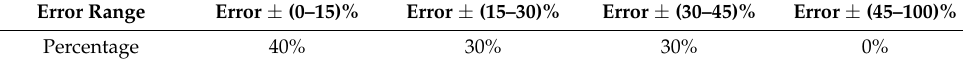
Table 11. Q–Q plot statistics for the two selected microsites (Charfashion and Monpura).